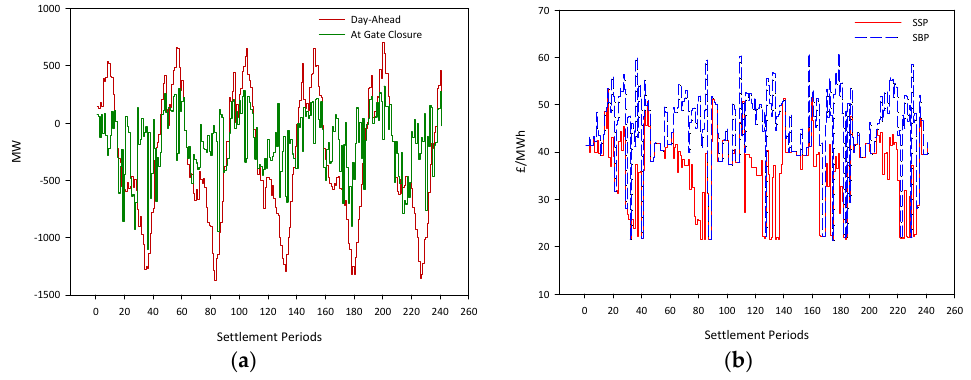
Figure 9. ( a ) System imbalance (IMBAL) at day ‐ ahead and gate ‐ closure positions; and ( b ) the system sell and system buy prices (SSP, SBP) over the corresponding time period. Case2: coal plants = 2, CCGT plants = 3, wind farms = 44.